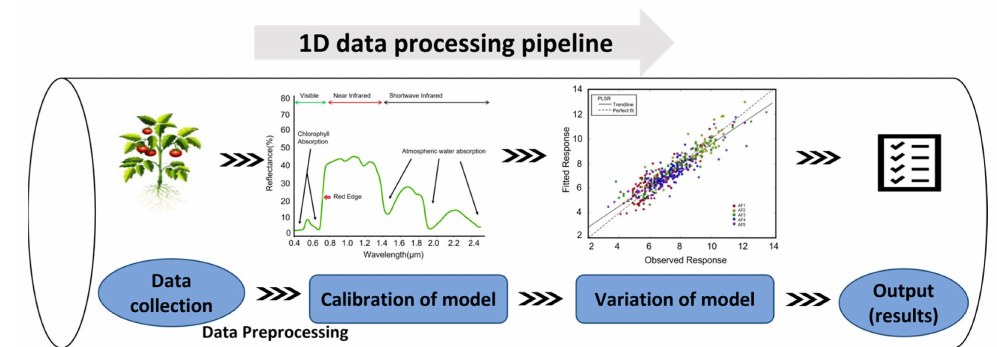
Figure 2. One-dimensional reflectance spectral data processing pipeline. After data collection, preprocessing is needed to remove the influence of irrelevant information and background noise in the results. Calibration of the model is used to find the correlation between the sample’s properties and absorbance, perform the fitness test of the model, and connect the attributes of samples with the preprocessed measured spectra. Validation of the model is used to predict the spectral signal of unknown samples based on the calibrated model and evaluate the model’s